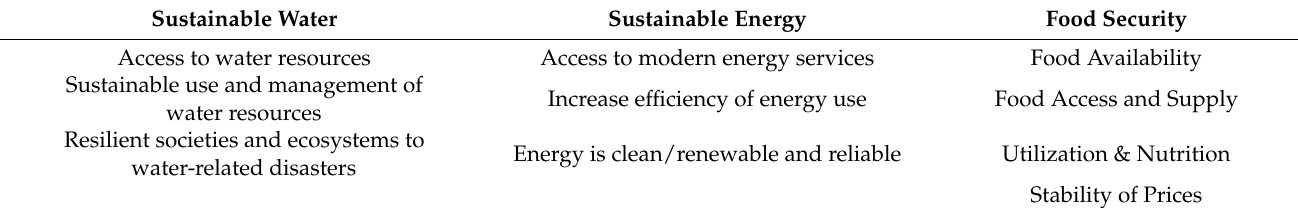
Table 1. Objectives for a Sustainable Nexus Approach [19].